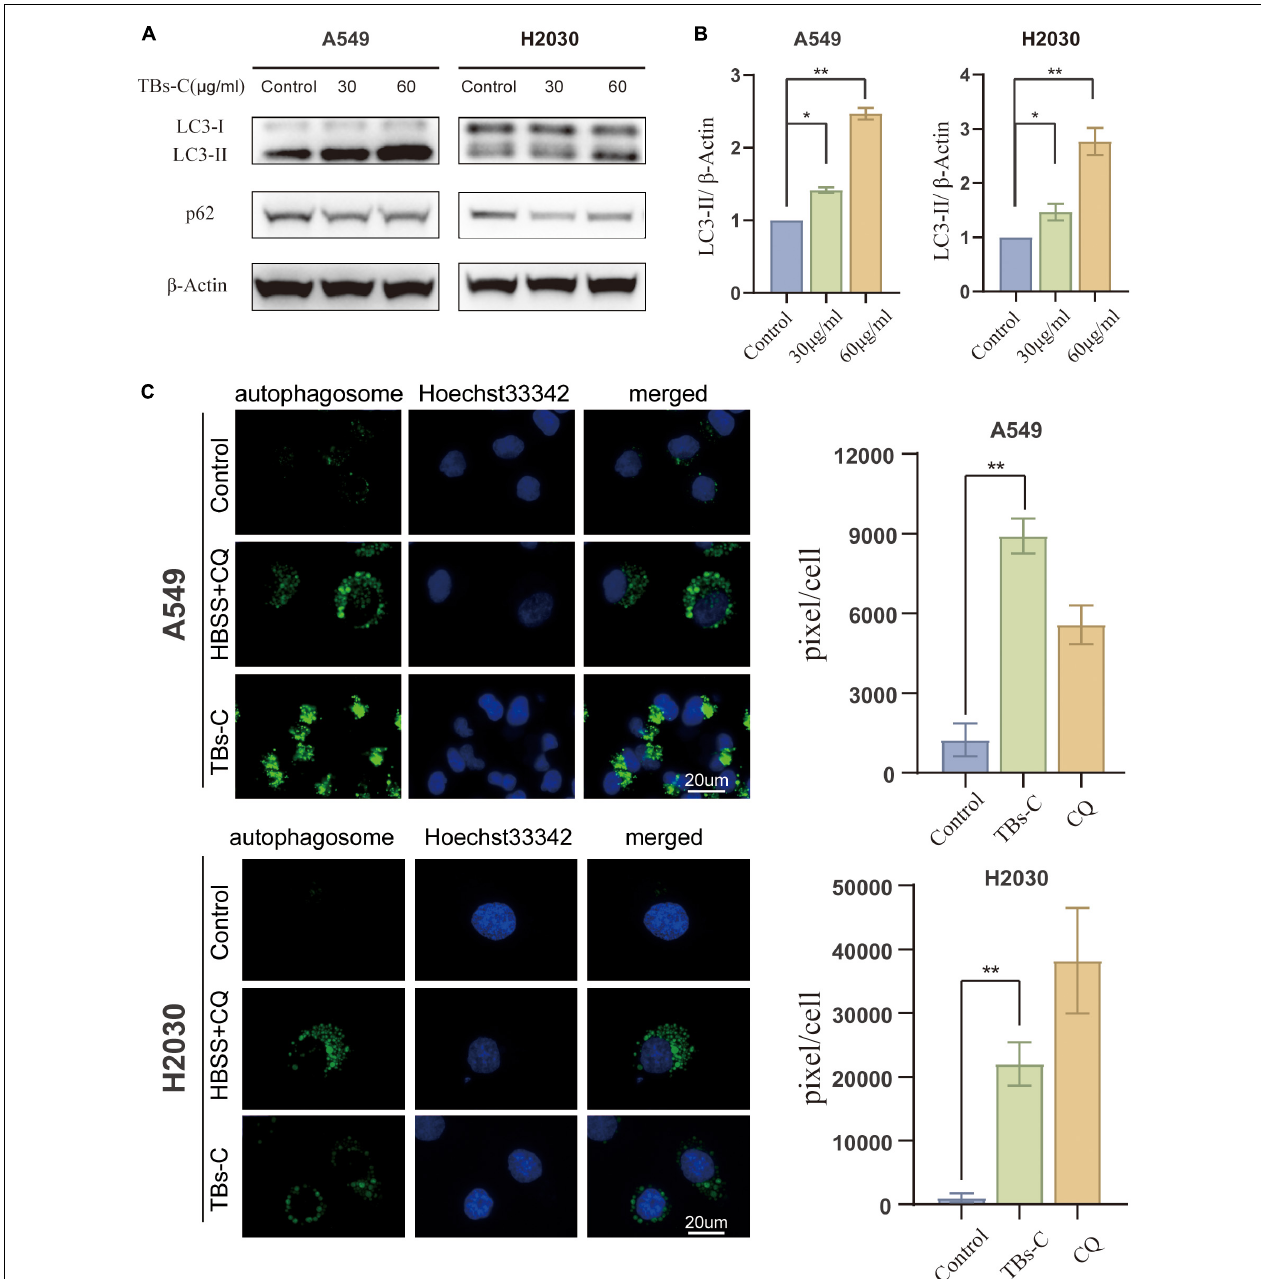
FIGURE 3 | Accumulation of autophagosomes in TBs-C treated lung cancer cells. (A) Western blotting results of the LC3 and p62 protein expression in TBs-C treated and untreated cells. (B) The densitometric analysis of the changes in the abundance of LC3-II normalized to the β -actin level. (C) The indicated cells were treated with TBs-C (60 µ g/mL) or untreated for 24 h. The cells were labeled with CYTO-ID R (cid:13) green detection reagent at the end of the treatment period to detect the autophagosomes. As a positive control for autophagosome accumulation, the cells were treated with HBSS in the presence of CQ (60 M) for 3 h. The puncta areas per cell are given in three randomly selected images for each culture condition, * p < 0.05, ** p <